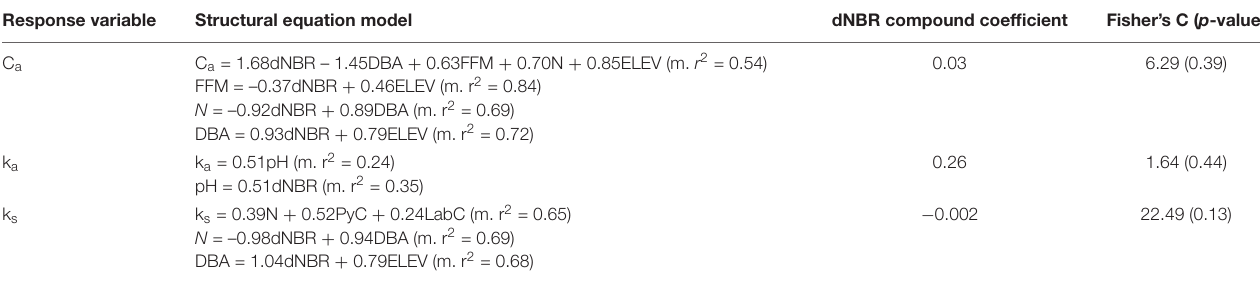
TABLE 2 | Structural equation models explaining direct and indirect links to C-pool